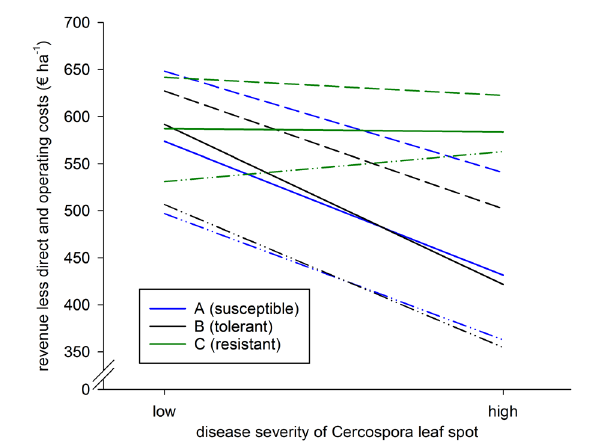
FIGURE 6 | Revenue less direct and operating costs of sugar beet varieties tested in 30 environments with low and 15 environments with high infection with CLS; Germany, 2014–2016. Connecting lines were added to illustrate changes in relative excellence. Susceptible (A) , tolerant (B) , and resistant (C) varieties were clustered according to disease severity of C. beticola and yield reaction to the disease. For details see text. Highest and lowest yielding varieties within each group are indicated by dashed and dash-dotted lines,